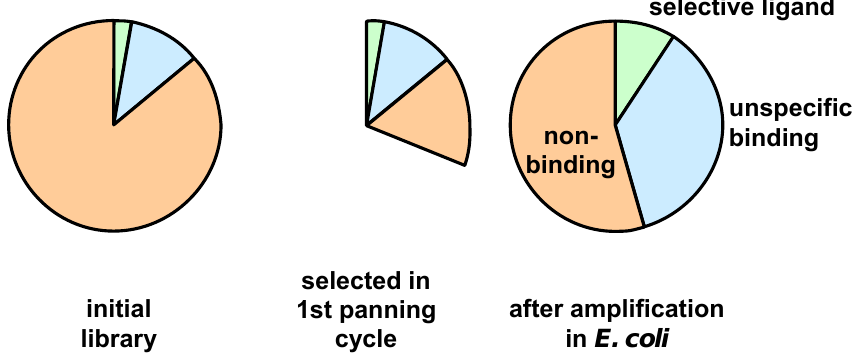
Figure 6. Schematic representation of the relative amplification of unspecific binders with a high propagation rate versus selective binders with moderate propagation rates after one panning round.